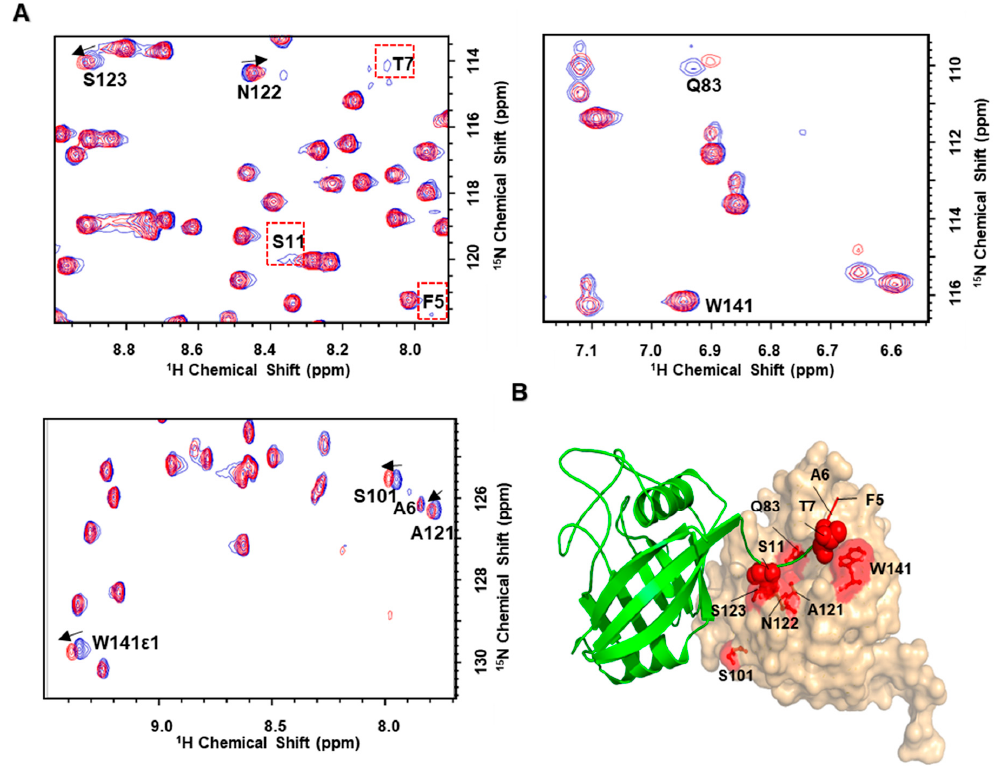
Figure 5. ( A ) Three particular regions of the superimposed 2D 1 H- 15 N HSQC spectra of 15 N-labelled Tv Cyp2 in the absence and presence of unlabeled Tv CyP2 3–18 . The cross peaks that show chemical shift perturbation or line width change between the two spectra are labelled. ( B ) Residues with shift perturbation or line width change are mapped onto the Tv CyP2 structure with residues from the active site shown in red sticks (red) and from the N-terminal segment in red spheres. site shown in red sticks (red) and from the N-terminal segment in red